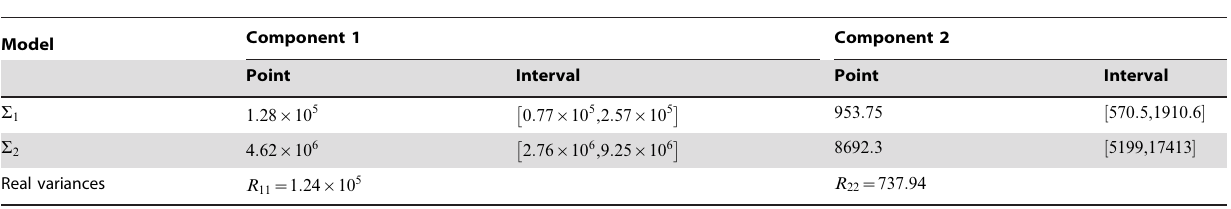
Table 1. Discrimination of the heat shock models.